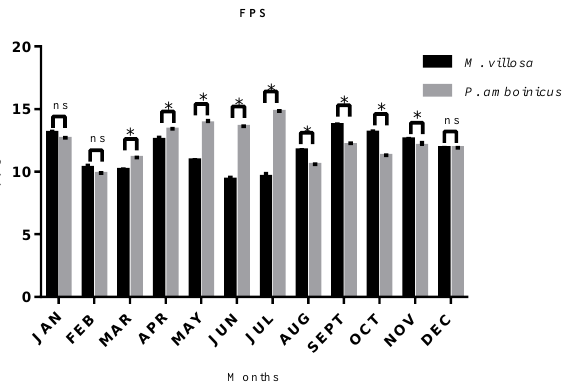
Figure 5. SPF of CEE of M. villosa and P. amboinicus and their statistical comparations throughout 12 months. ns = nonsignificant. * statistical 12 months. ns = nonsignificant. * statistical difference